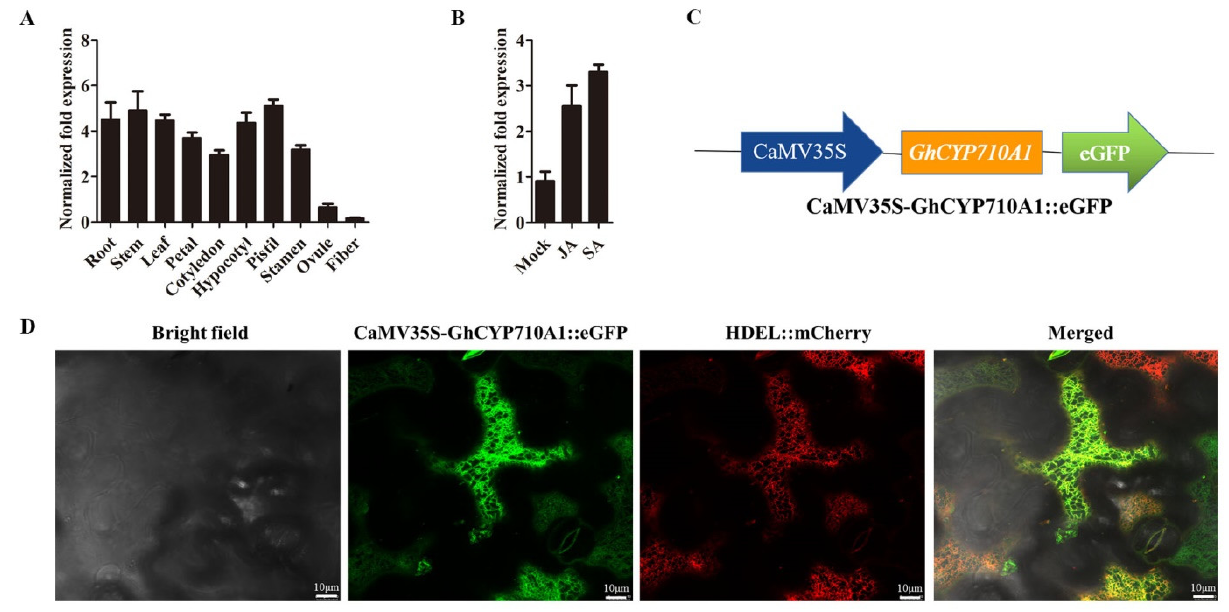
Figure 3. The expression patterns and subcellular localization of GhCYP710A1. ( A ) The expression patterns of GhCYP710A1 in various tissues and organs. Ovule (with fiber cells) was taken from 0-DPA ovary; fiber was taken from 10-DPA ovary. ( B ) The expression of GhCYP710A1 responded to jasmonic acid (JA) and salicylic acid (SA). Mock: the ovule (with fiber cells) grew on the BT medium; JA: the ovule (with fiber cells) grew on the BT medium containing JA; SA: the ovule (with fiber cells) grew on the BT medium containing SA. Error bars represent standard deviation (SD) of three independent replicates. ( C ) Diagram of the CaMV35S-GhCYP710A1::eGFP-T-NOS cassette. ( D ) Subcellular localizations of GhCYP710A1; HDEL::mCherry was used as a positive control indicating endoplasmic reticulum localization. Merge: The merged images of Bright Field, CaMV35S-GhCYP710A1::eGFP and HDEL::mCherry; scale bar = 10 µ m.